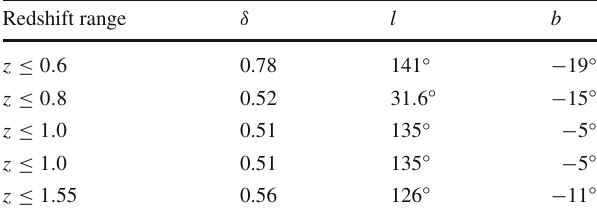
Table 7 Similar to Table 6, but for the Constitution data